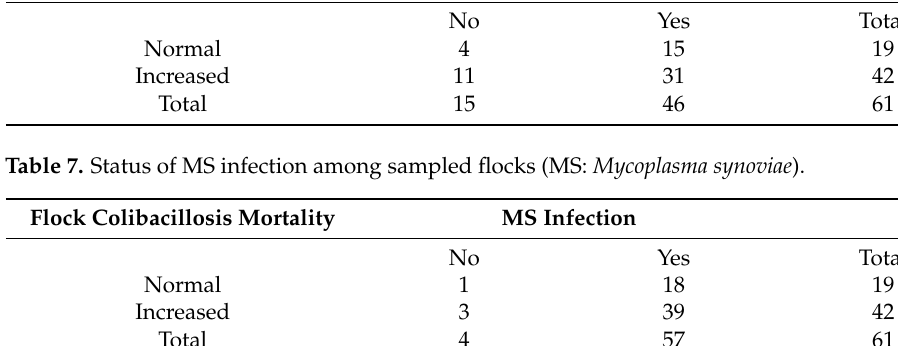
Table 6. Status of MG infection among sampled flocks (MG: Mycoplasma gallisepticum) . Flock Colibacillosis Mortality